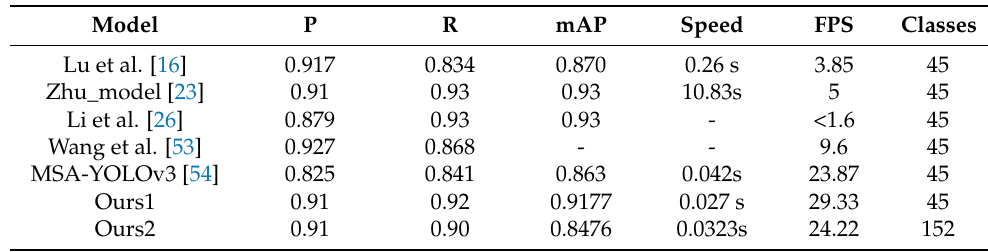
Table 4. Detection Results of Different Detection Models on TT100K, “-” Means No Parameters Are